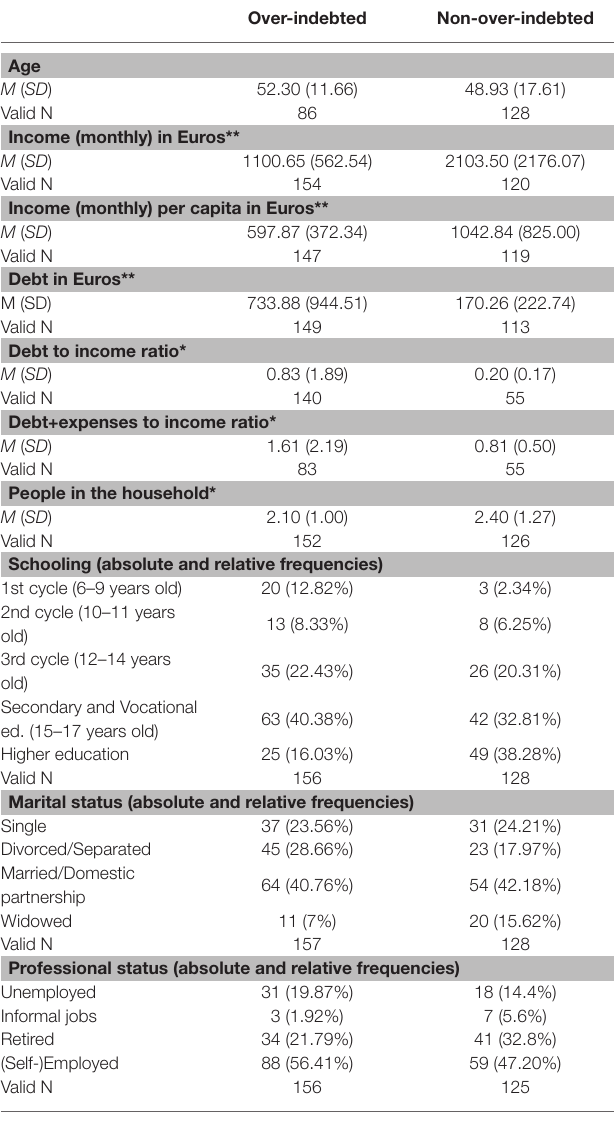
TABLE 1 | Socio-demographic characteristics of over-indebted and non-over-indebted samples of participants.